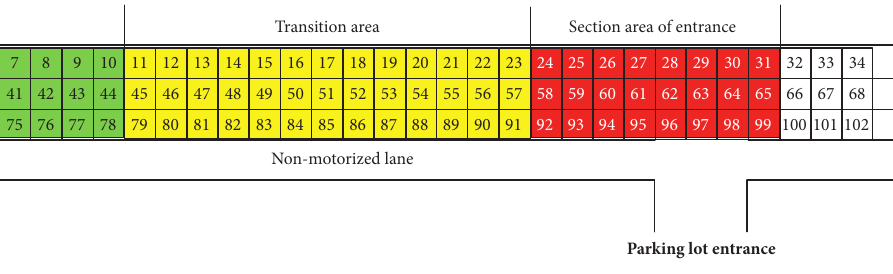
Figure 7: Diagram of the division of the entrance and